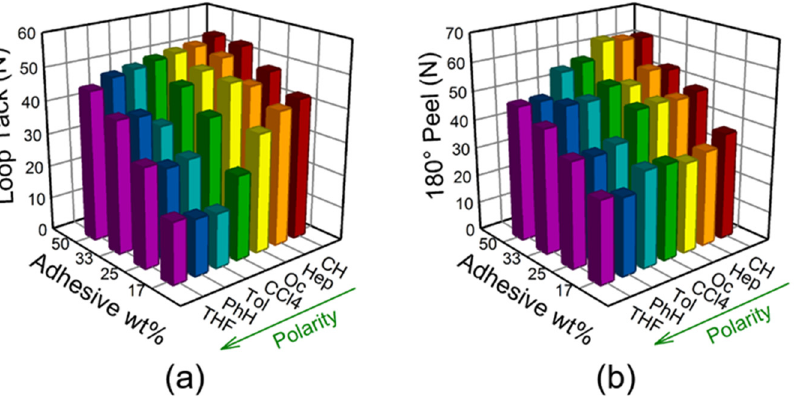
Figure 4. Quick bond strength (average values) tested with different types of solvents and different adhesive weight percent in the prepared solutions: ( a ) loop tack, ( b ) 180° peel adhesion forces.